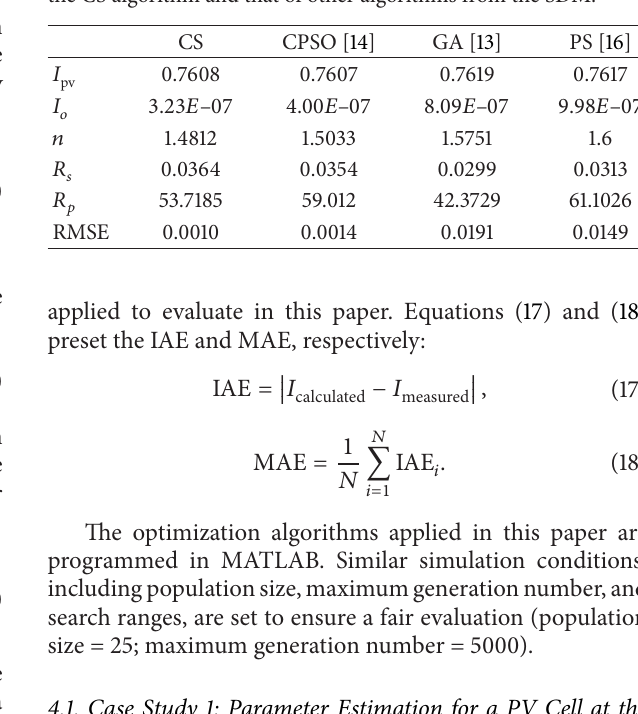
Table 1: A comparison between the parameter results obtained by the CS algorithm and that of other algorithms from the